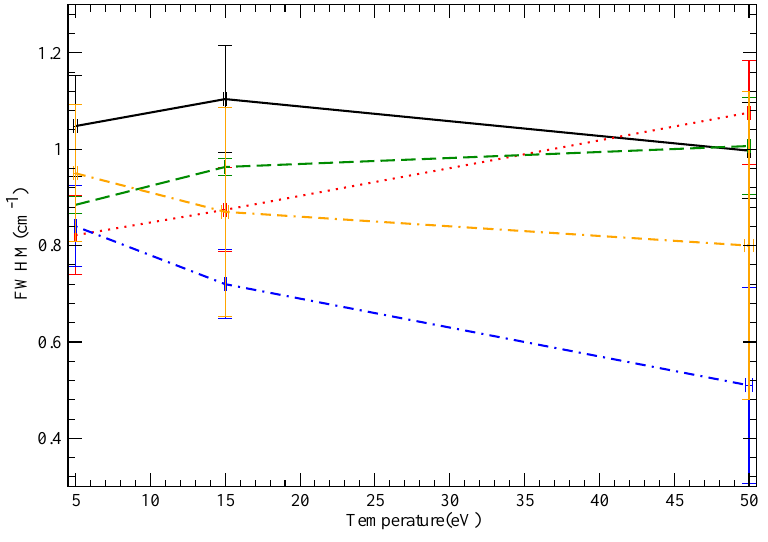
Figure 1. A comparison of LiI 2s-2p transition widths as computed by SCP (solid black), SimU (dotted red), Simulation (dashed green) and Starcode with (dash-dotted blue) and without (dash-double dotted orange) penetration accounted for.